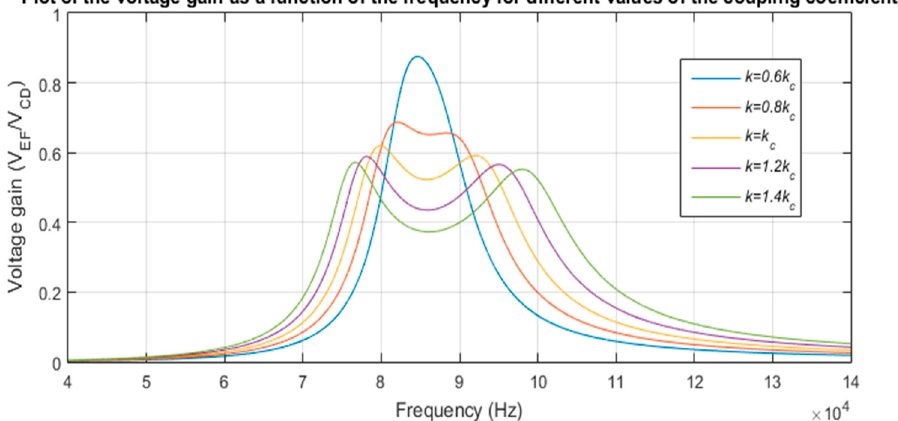
Figure 9. Evolution of the voltage gain as a function of the frequency for different values of the coupling coefficient and for a fixed load.